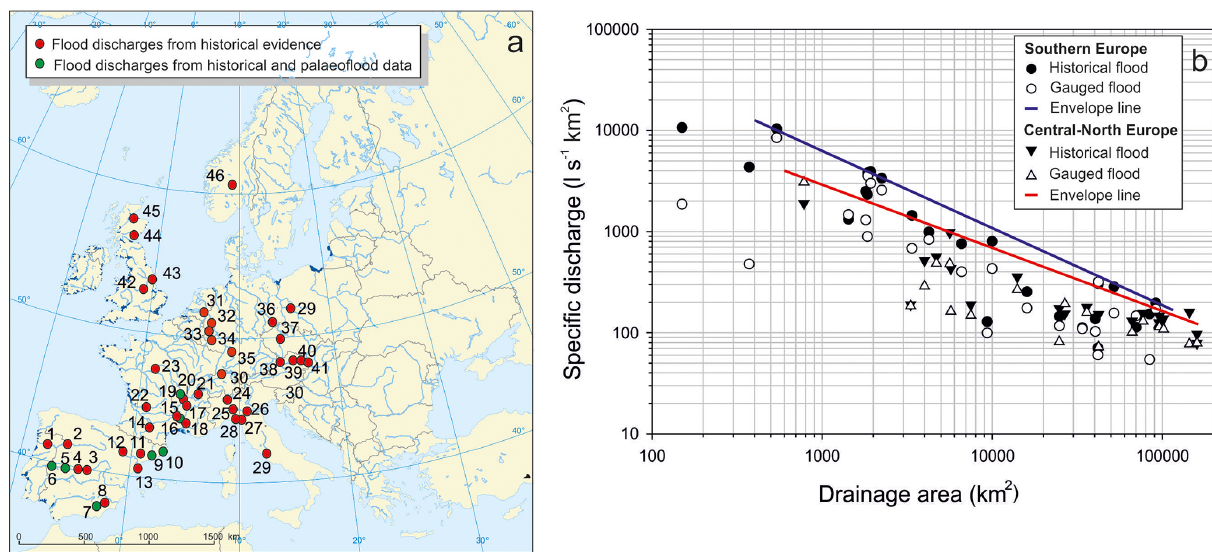
Figure 7. (a) Major rivers and streams of Europe and studied sites with multiple historical flood discharge estimates. Numbers refers to places cited in Table 1. (b) Maximum specific discharge (ls − 1 km 2 ) of the largest historical and instrumental floods recorded in the sites referred in Table 1. Southern Europe includes sites from Portugal, Spain, Italy and France (except the Dordogne, Isère, Loire, Rhone and Garonne rivers), and central-northern Europe the rest of the rivers. Lines are envelope boundaries of the largest specific discharges for these two data sets. Most of the historical specific discharges are above the instrumental ones, except some rivers in central-northern